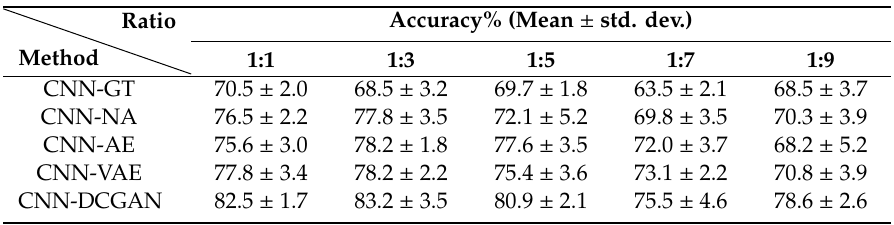
Table 7. Classification Accuracy of the methods for the BCI competition IV dataset 2b (baseline: 80.6 ± 3.2%).